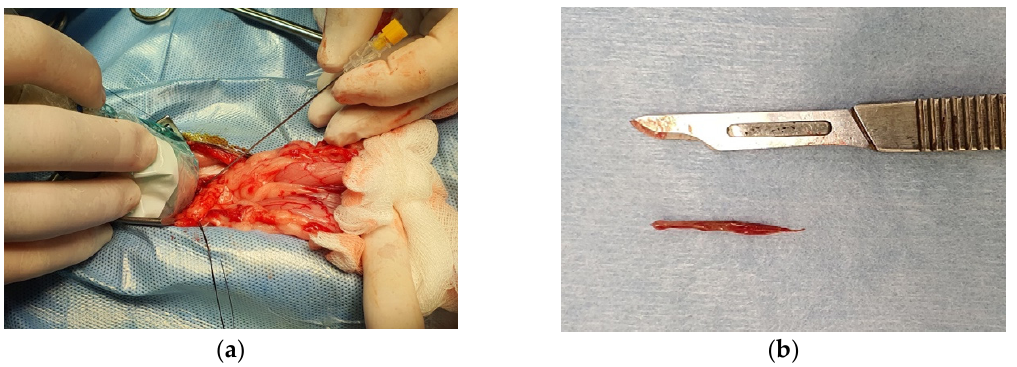
Figure 2. Photograph of the microconvex probe encased in a sterile protective cover and positioned on the ventral surface of the prostate during the surgery; a spinal needle was introduced, under intraoperative ultrasonographic guidance, through the prostate towards the tip of the awn ( a ). Photograph of the awn after the removal from the prostate ( b ).